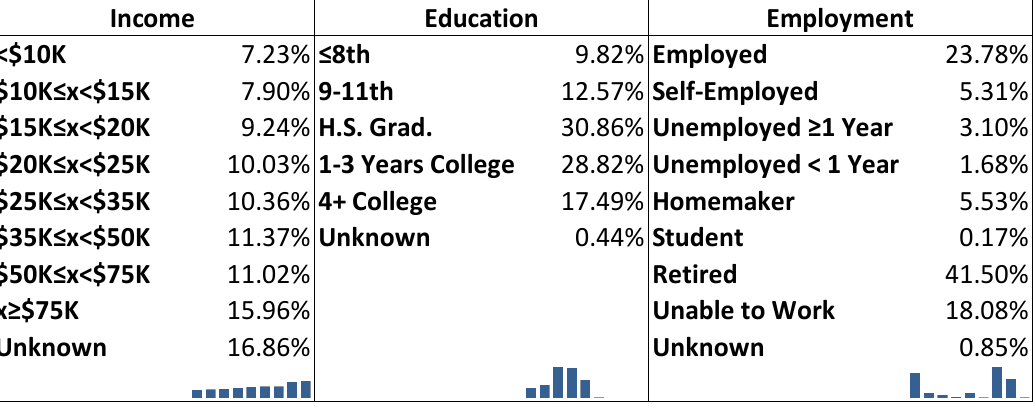
Figure 4. Marginal distributions for income, education, and employment.